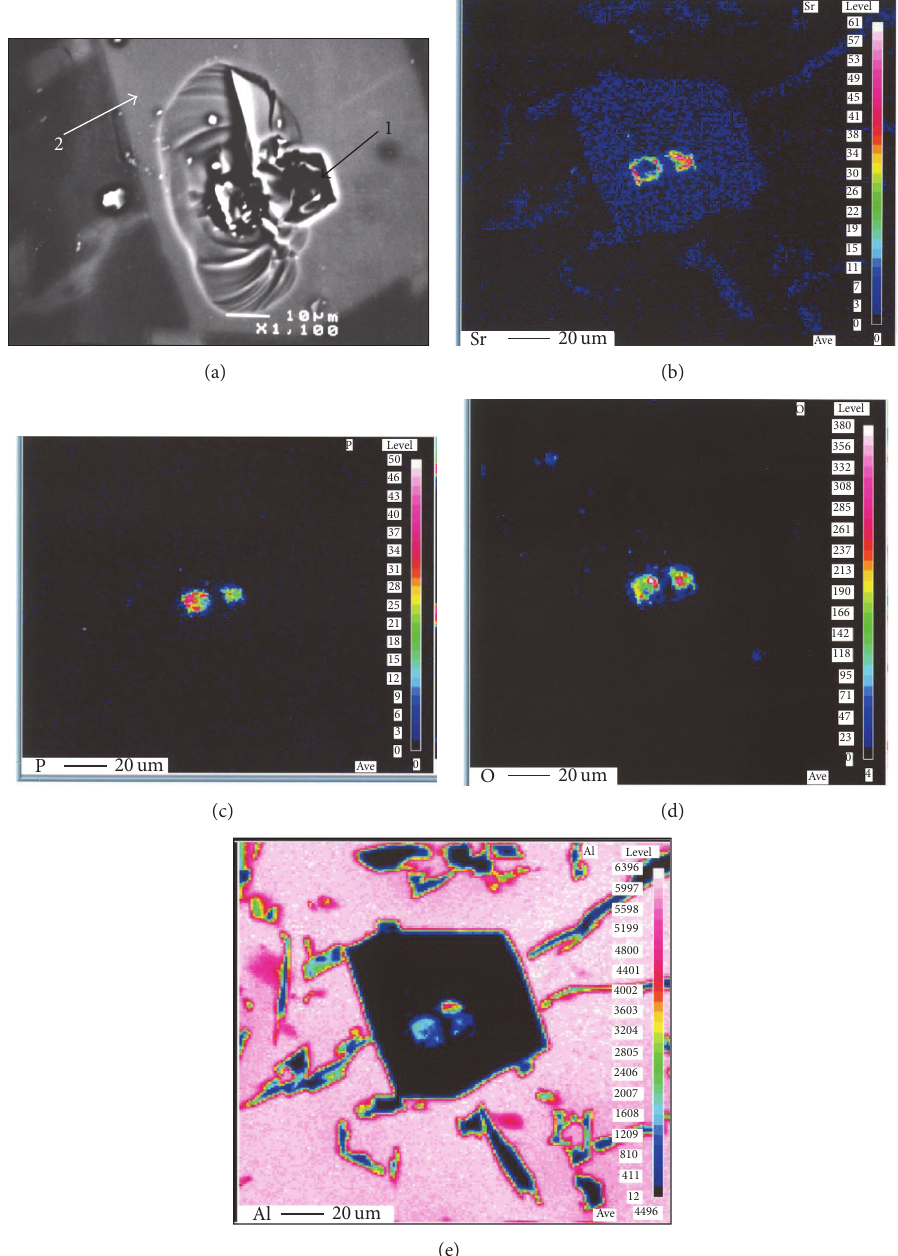
Figure 2: (a) Backscattered electron image, (b) Sr, (c) P, (d) O, and (e) Al distribution in the black